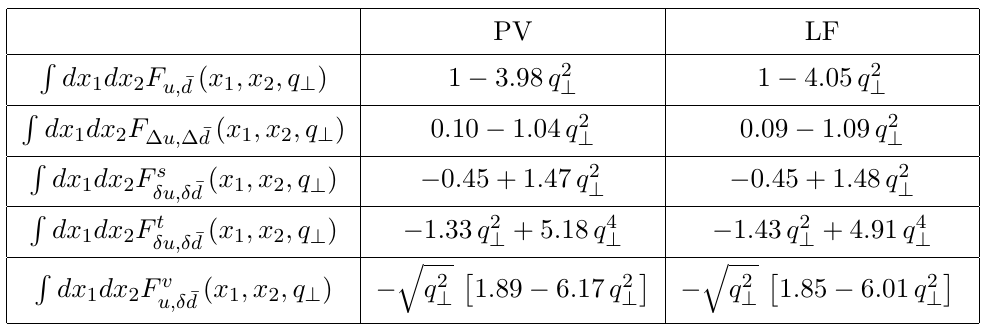
Table 2 . Behavior of the function R dx 1 dx 2 F a